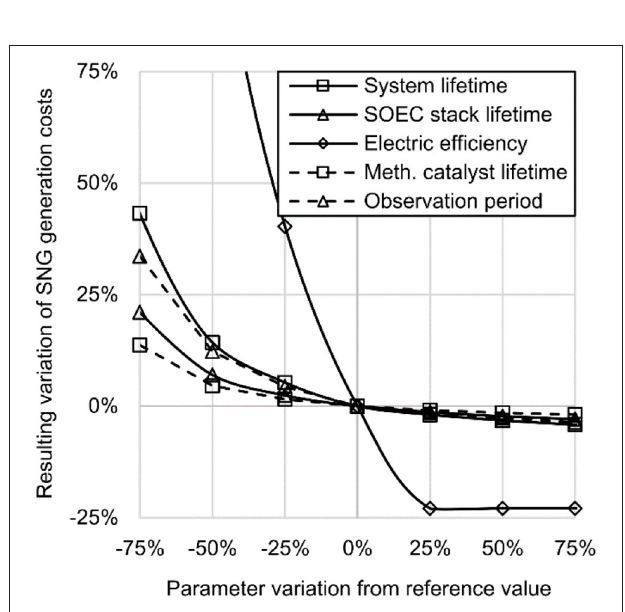
FIGURE 10 | Sensitivity analysis of non-linear impact parameters for the 2030 reference